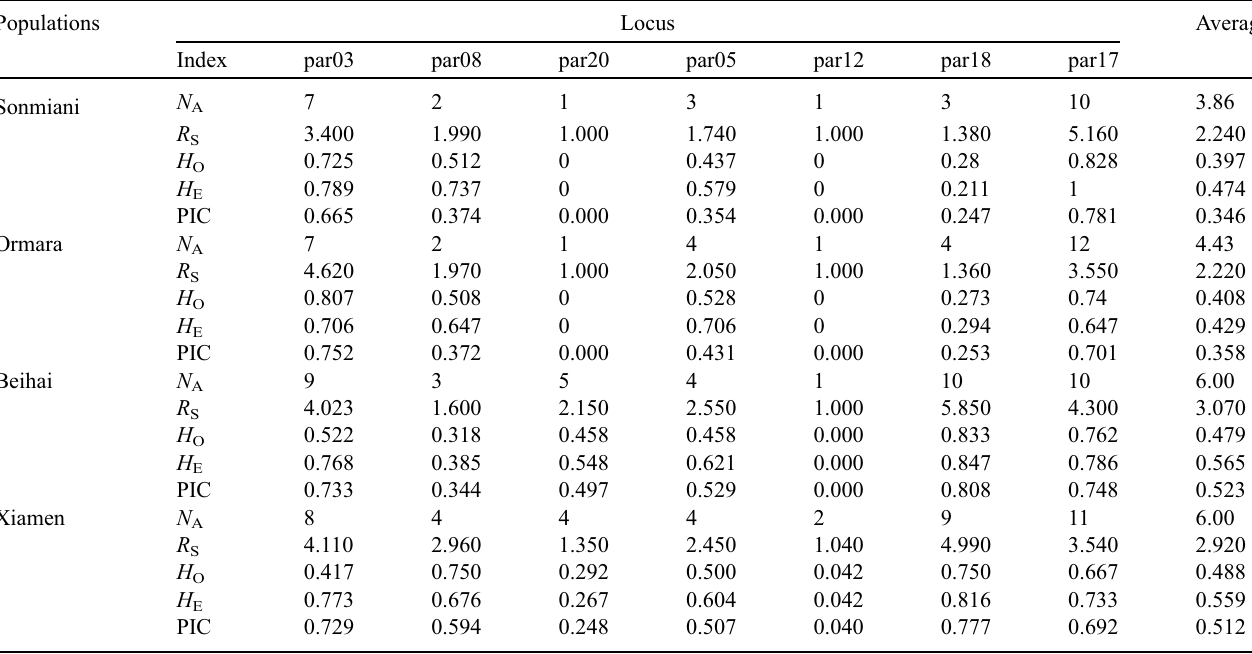
Table 5. Summary statistics for the variability of seven polymorphic microsatellite loci in four P. chinensis